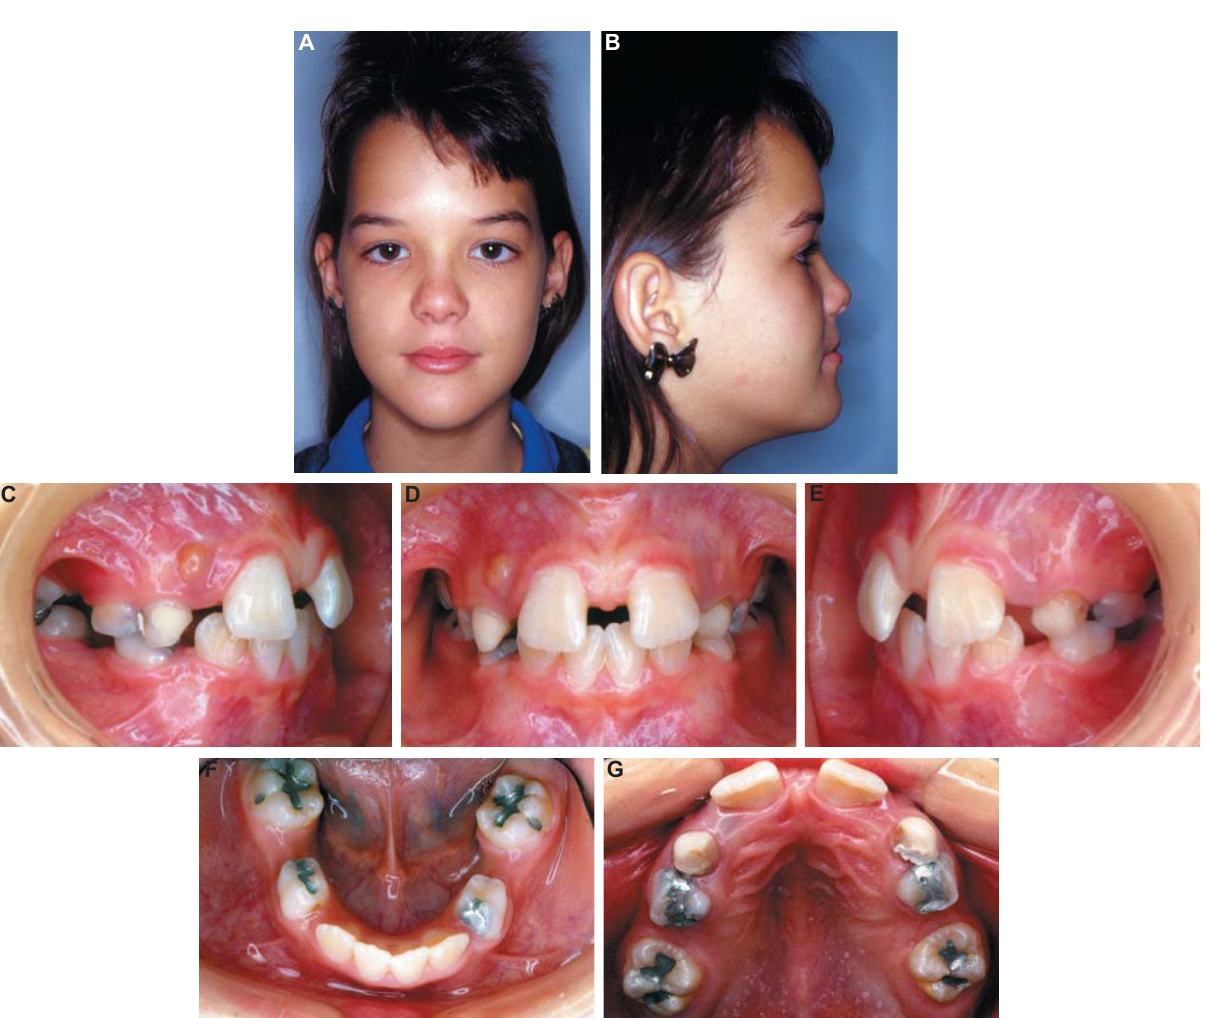
Figure 2- Pretreatment extraoral (A and B) and intraoral (C-G) photographs (the parents authorized the publication of these